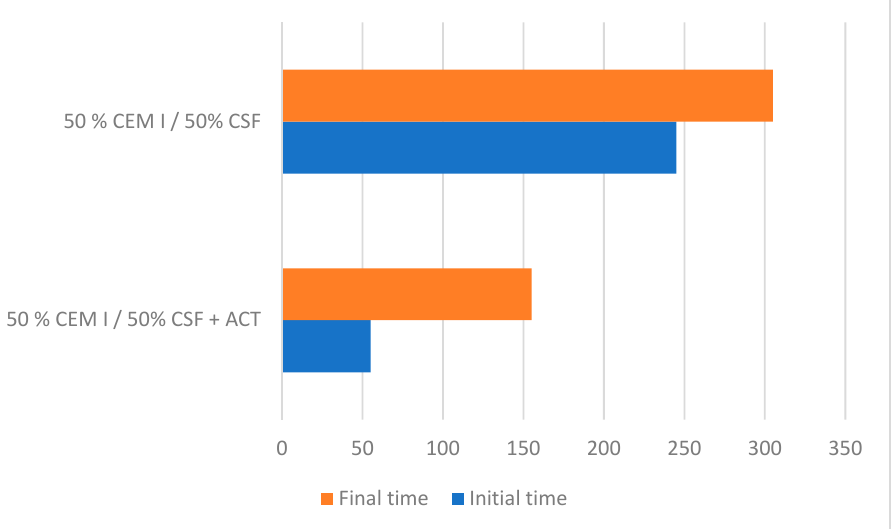
Figure 10. Cement setting times with setting retarder.